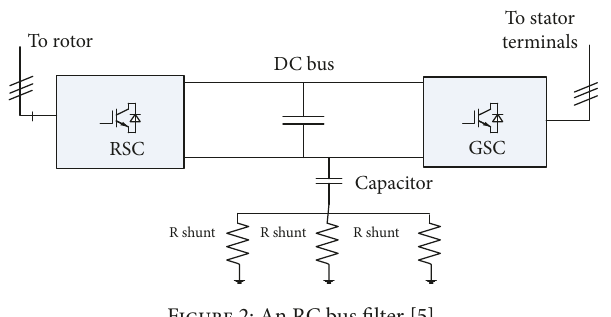
Figure 2: An RC bus filter